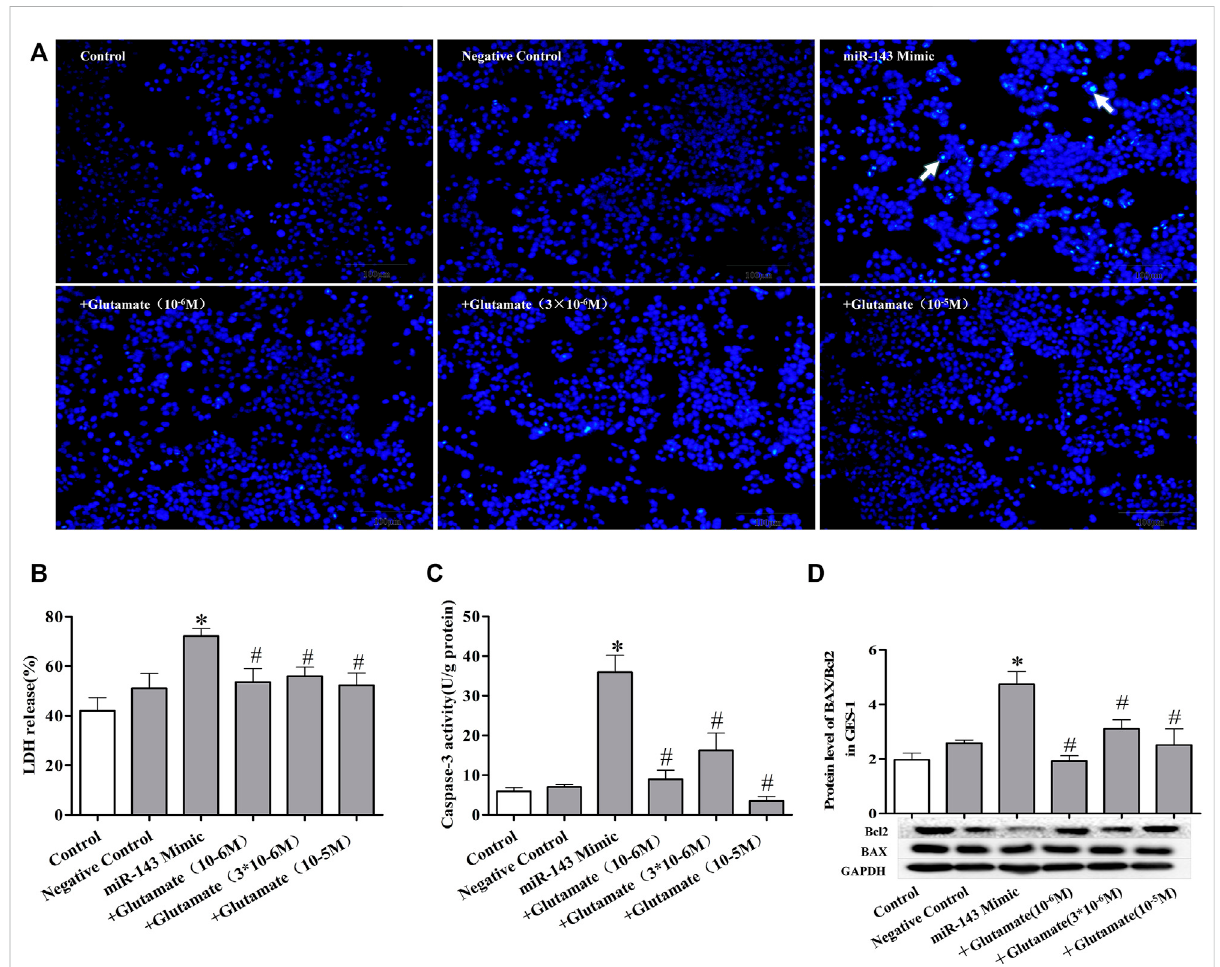
FIGURE 5 Cell damage induced by miRNA mimics can be attenuated by exogenous glutamate supplementation. (A) Protective effect of glutamate on gastricmucosalepithelialcellapoptosisaftertreatmentwithmimicmiR-143(Hoechststaining,×100). (B) LDHrelease. (C) Caspase-3activity. (D) The ratio of BAX/Bcl-2 in gastric mucosal epithelial cells. Data are expressed as mean ± standard error ( n = 3). # p < 0.05 vs. MicroRNAs mimic, * p < 0.05 vs. Negative